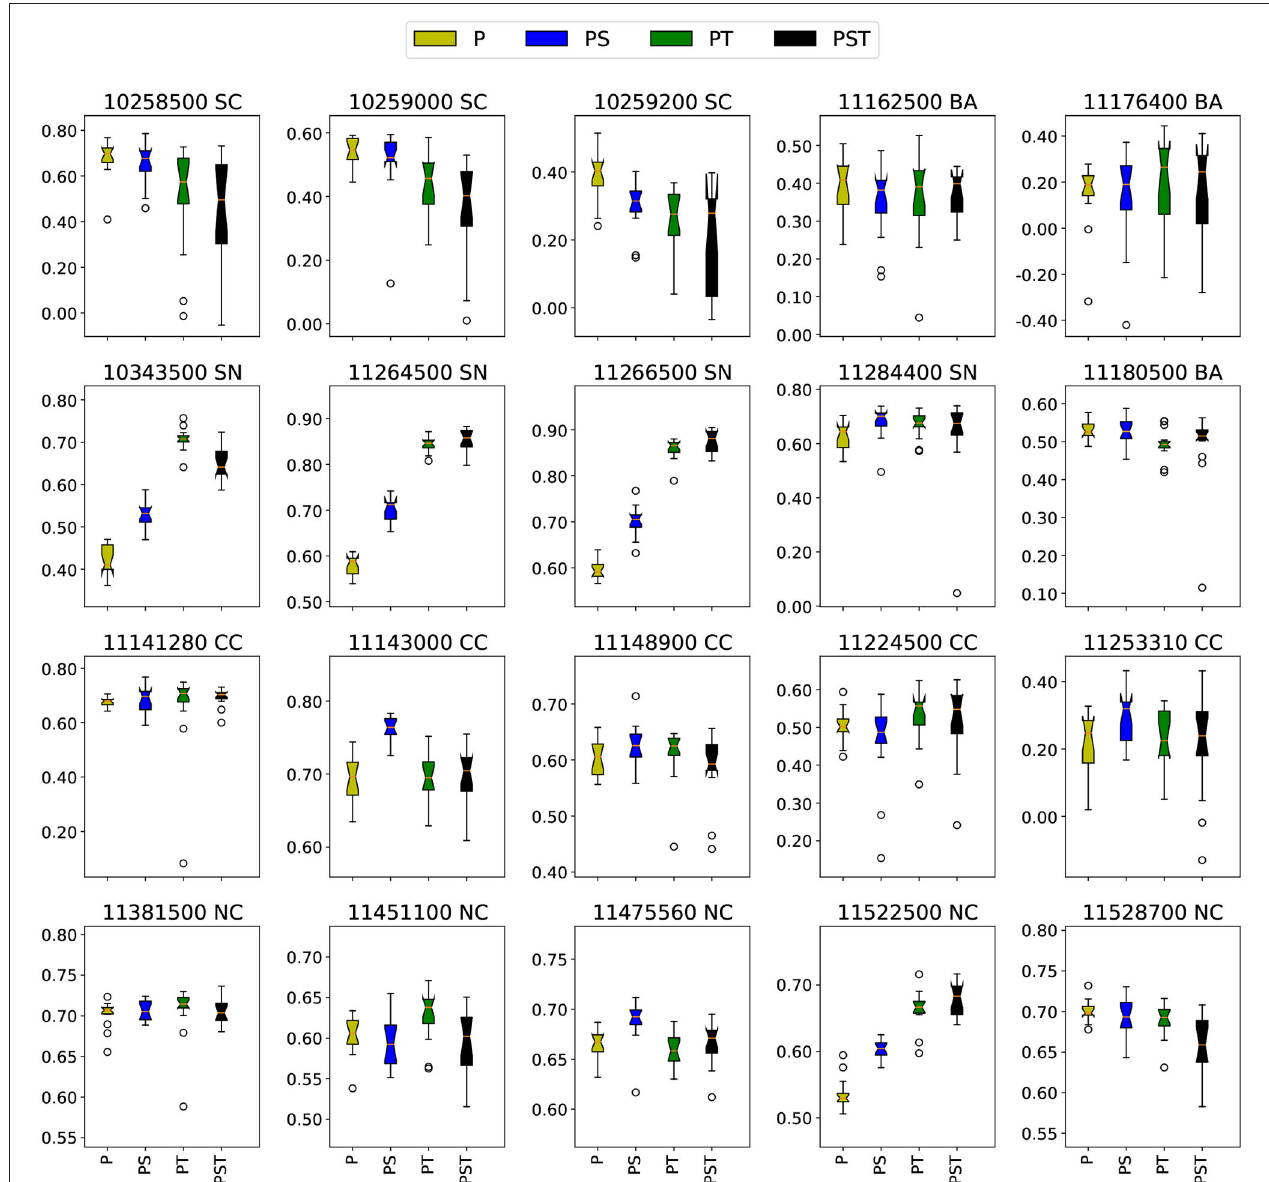
FIGURE 4 | Ensemble prediction comparison for all basins with different reduced TCNN